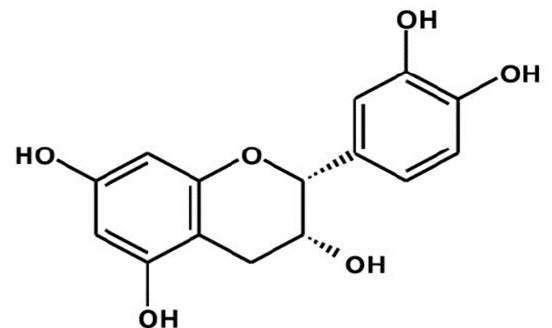
Figure 1. Molecular structure of ( − )-epicatechin. The ( − )-epicatechin molecule constitutes the most abundant flavonoid in cocoa [20], and, in comparison to ( − )-epigallocatechin-3-gallate (EGCG), it has not shown any side e ff ects. Although these features make ( − )-epicatechin an interesting molecule for the development of novel phytopharmaceuticals against cancer, little is understood about the mechanism of action involved. In the current study, the anticancer activity of ( − )-epicatechin was investigated at the molecular level, focusing on apoptotic cell death in breast cancer cells.